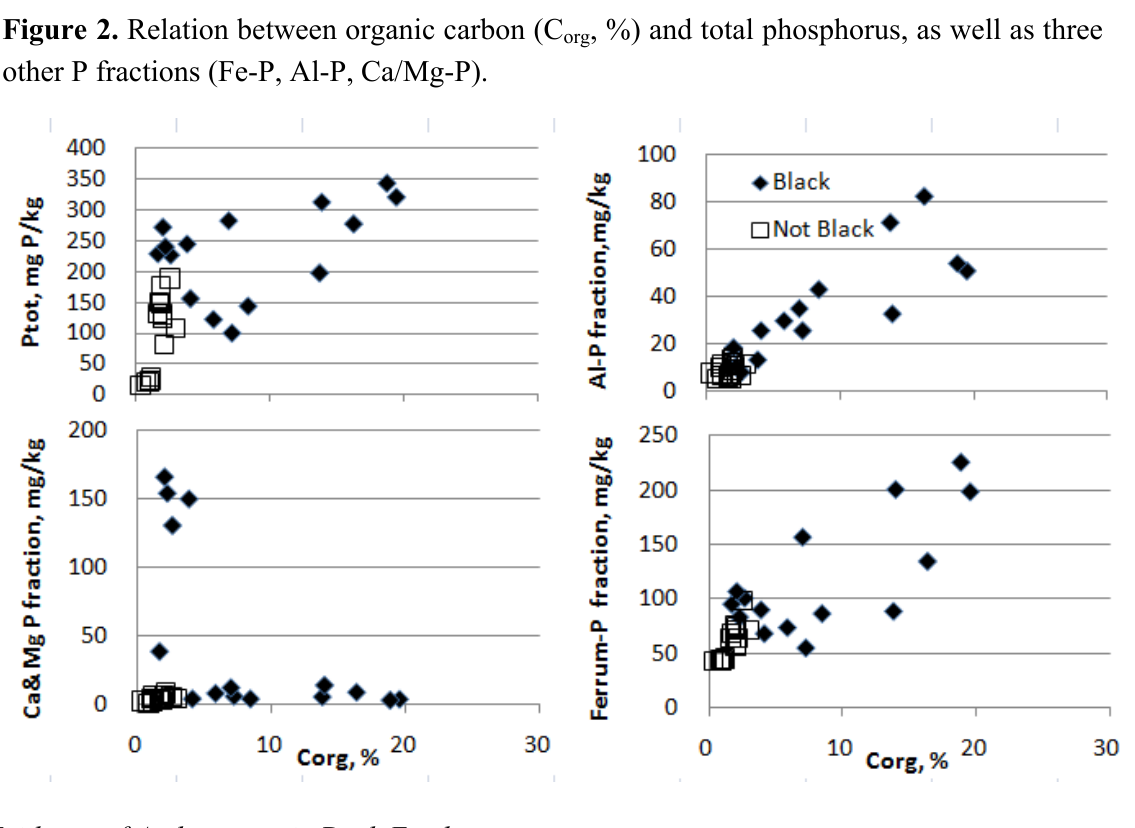
, %) and total phosphorus, as well as three org